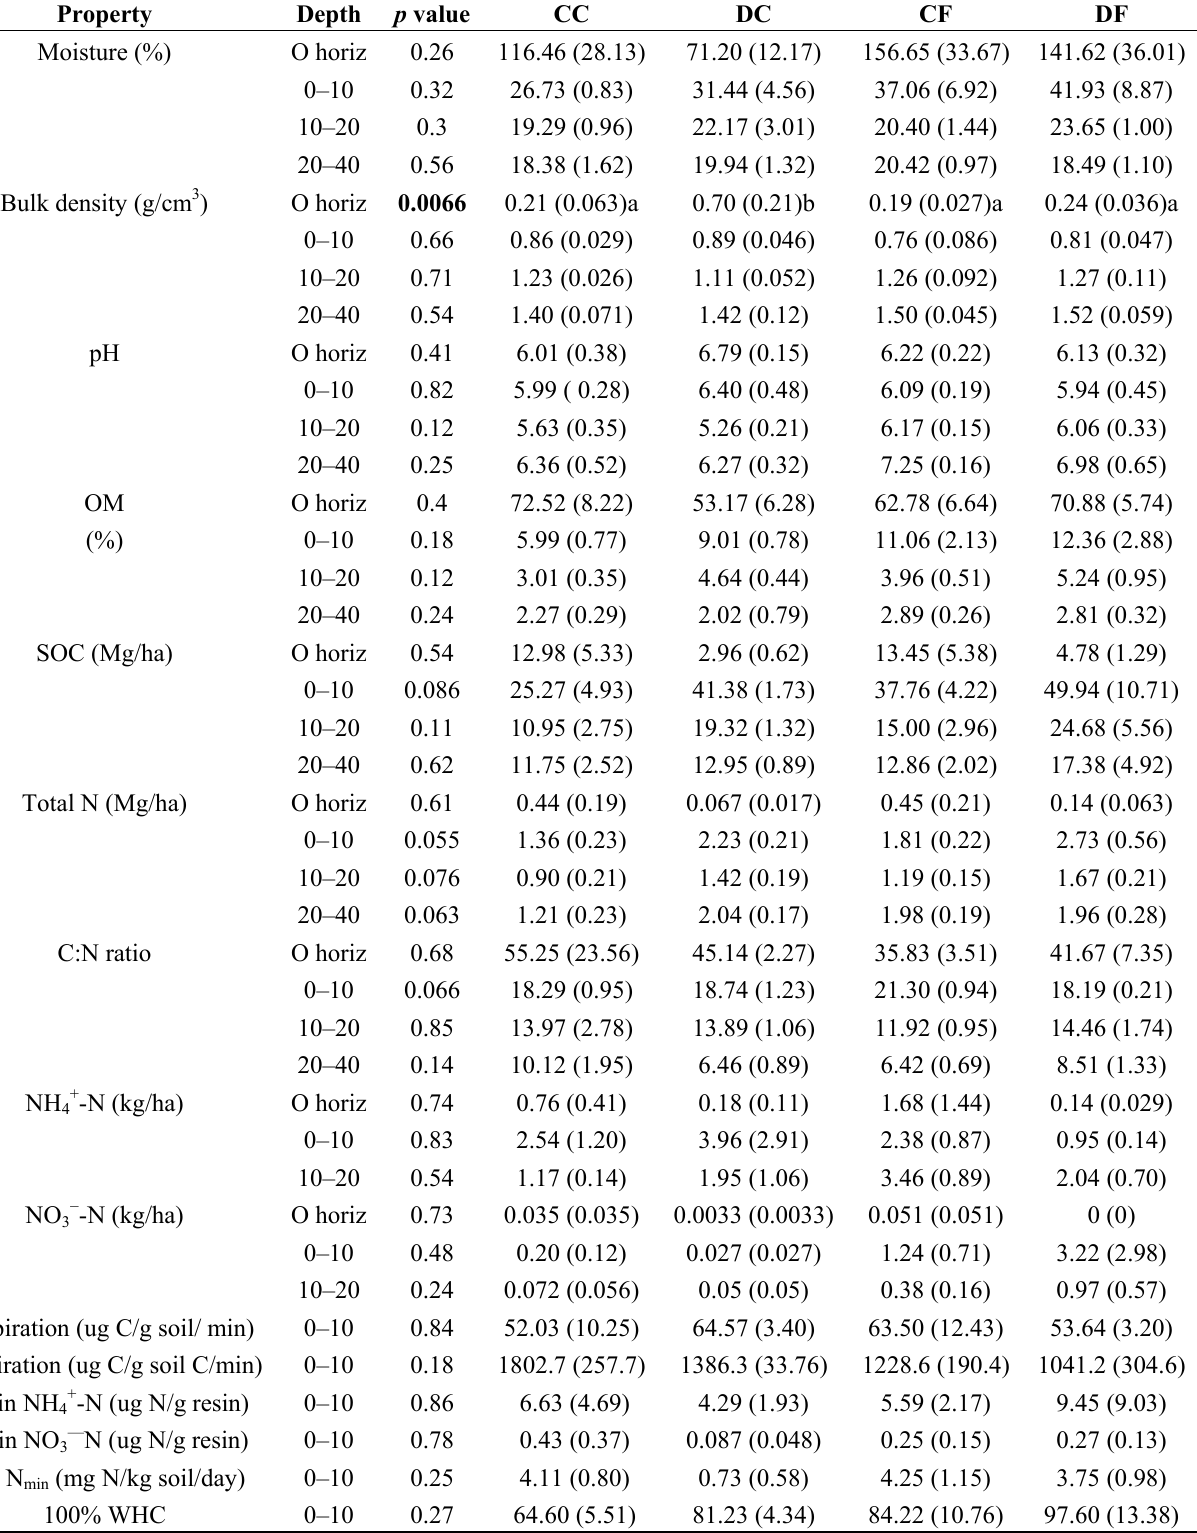
Table 5. Ecosite cluster property averages (standard errors) by